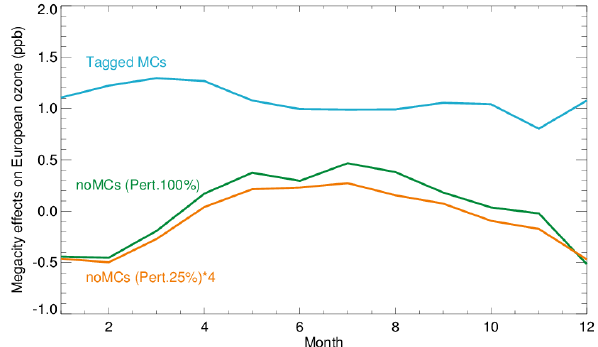
Fig. 8. European surface ozone attributed to megacity emissions as a monthly average for the tagging and perturbation techniques. An annihilation scenario and a 25% increase scenario are compared, where the 25% increase scenario is scaled to 100% for comparison purposes.